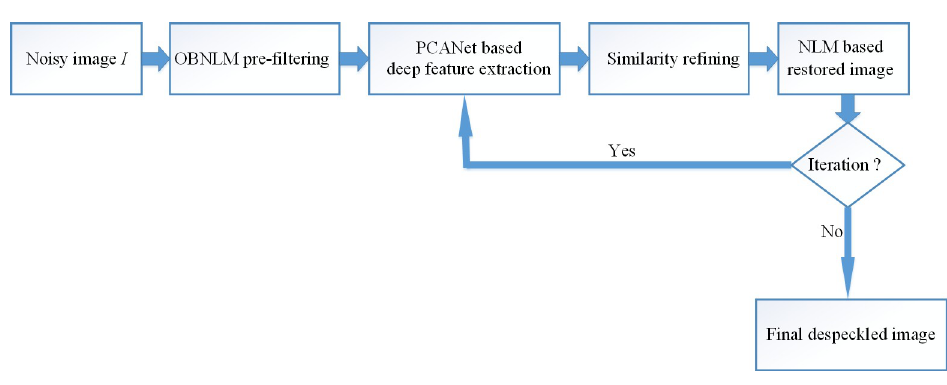
Fig 3. The scheme of the proposed